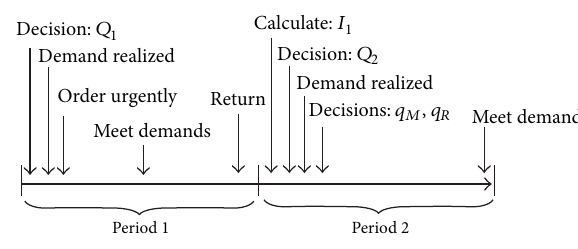
Figure 1: System event